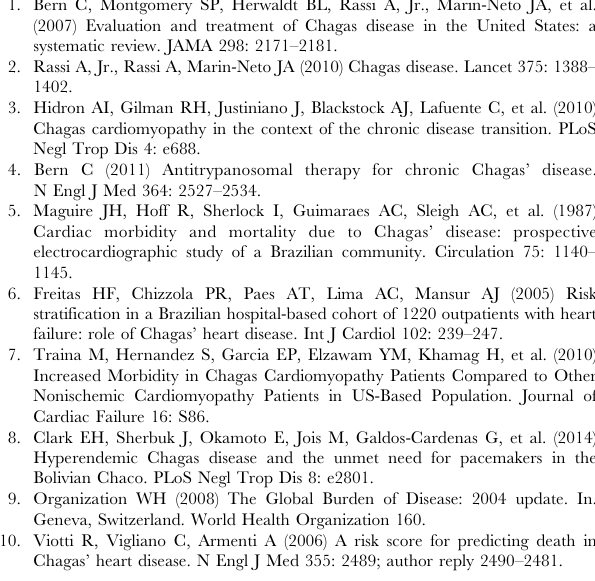
Figure S2 Correlation between stage and biomarker levels, stratified by T. cruzi infection status. 2a: T. cruzi -infected individuals. 2b: Uninfected individuals. Rho values are shown. Significant correlations (p , 0.05) are shaded gray (positive correlation) and black (negative correlation). Figure S3 Correlation between biomarker levels among T. cruzi -infected individuals stratified by stage. 3a: Stage AB. 3b: Stage CD. Rho values are shown. Significant positive correlations (p , 0.05) are shaded gray. No significant negative correlations were observed. Table S1 Basic characteristics and risk factors by T. cruzi infection status in all individuals meeting inclusion criteria. Table S2 ECG findings suggestive of Chagas disease by T. cruzi infection status for individuals included in biomarker analysis. Table S3 Comparisons of biomarkers and biomarker ratios by stage within T. cruzi -infected (Tc + ) and uninfected (Tc 2 )